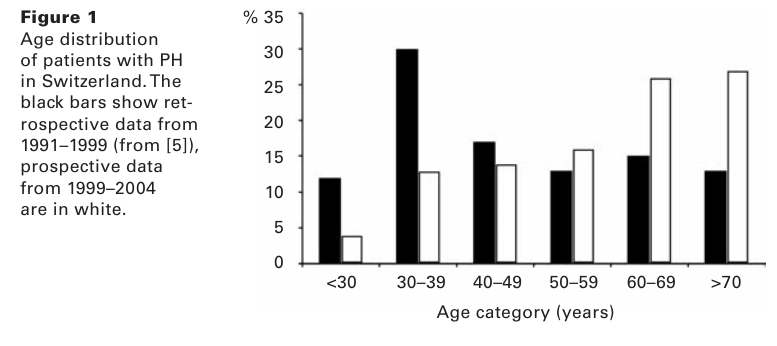
Figure 1 Age distribution of patients with PH in Switzerland. The black bars show ret- rospective data